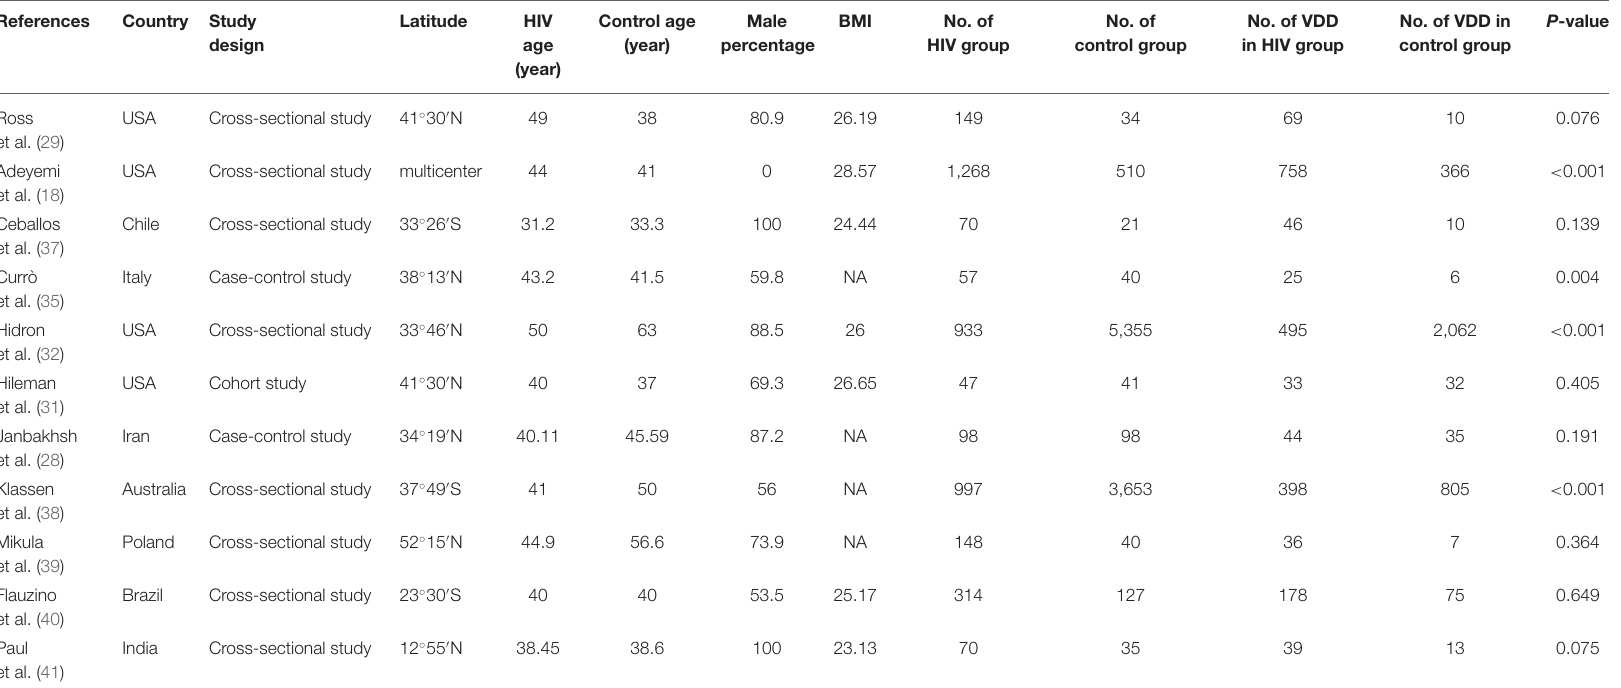
TABLE 2 | Characteristic of included studies for assessing the Vitamin D Deficiency